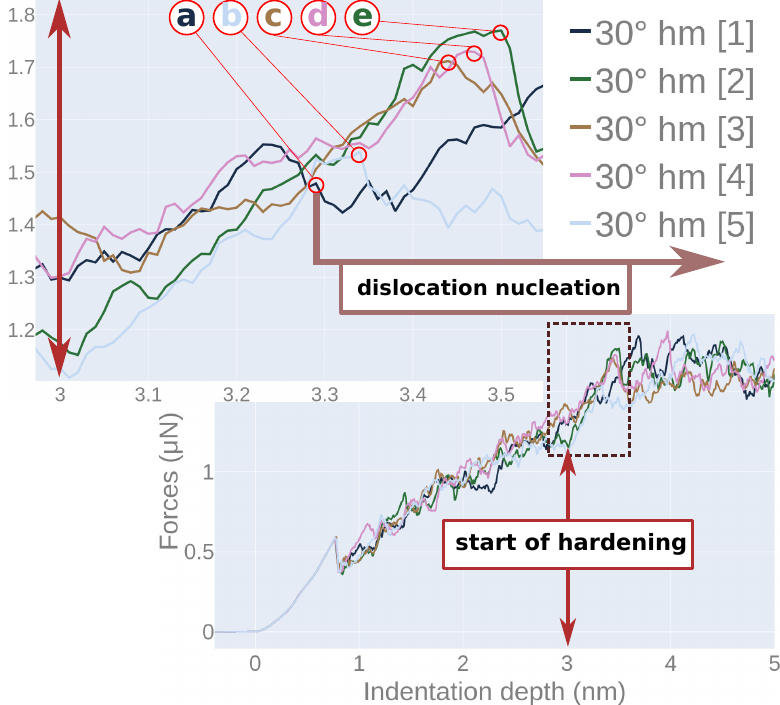
Figure 5. Force–depth curves for indentation into Ni containing a 30 ◦ hm grain boundary in each individual indentation event, cf. Figure 3a. Upper insert shows a zoom into the indentation region where hardening starts. Circled points in the zoom, a–e , indicate indentation depth where dislocations start nucleating in the lower Ni block.